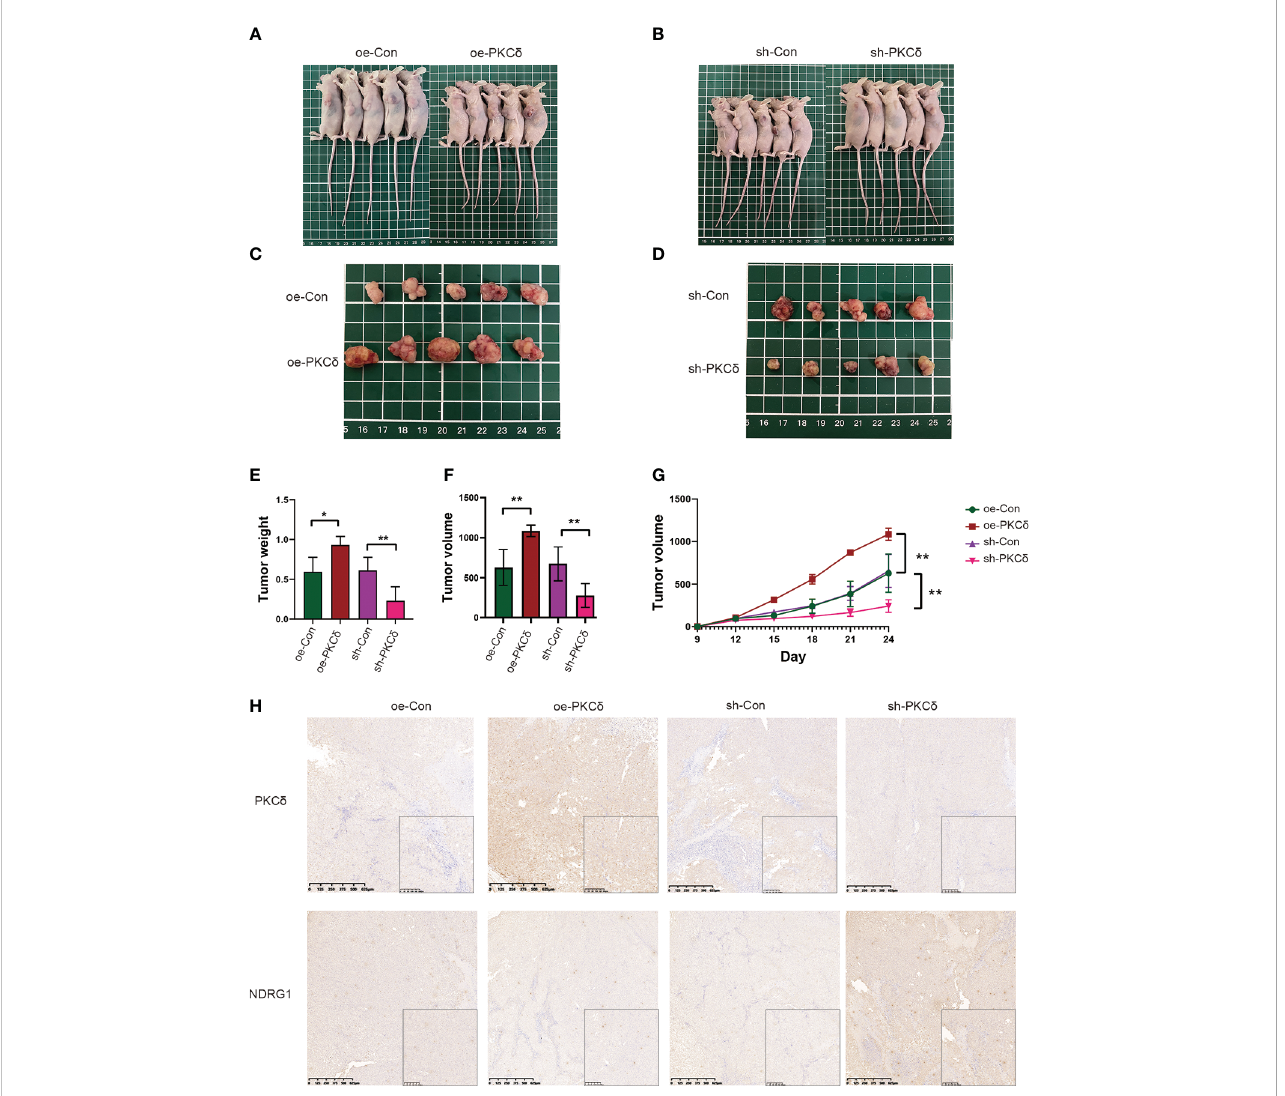
FIGURE 8 PKC d enhanced tumor growth in vivo . Morphological observation of tumors formed after injection of nude mice with RKO cell lines that with PKC d overexpression (A, C) or silencing (B, D) . (E) Average weight of xenografts. (F) Weight of tumors taken from nude mice after 24 days of growth. (G) Growth curves of tumors. (H) The representative IHC staining images of PKC d and NDRG1 in tumor xenografts. *p < 0.05, **p <